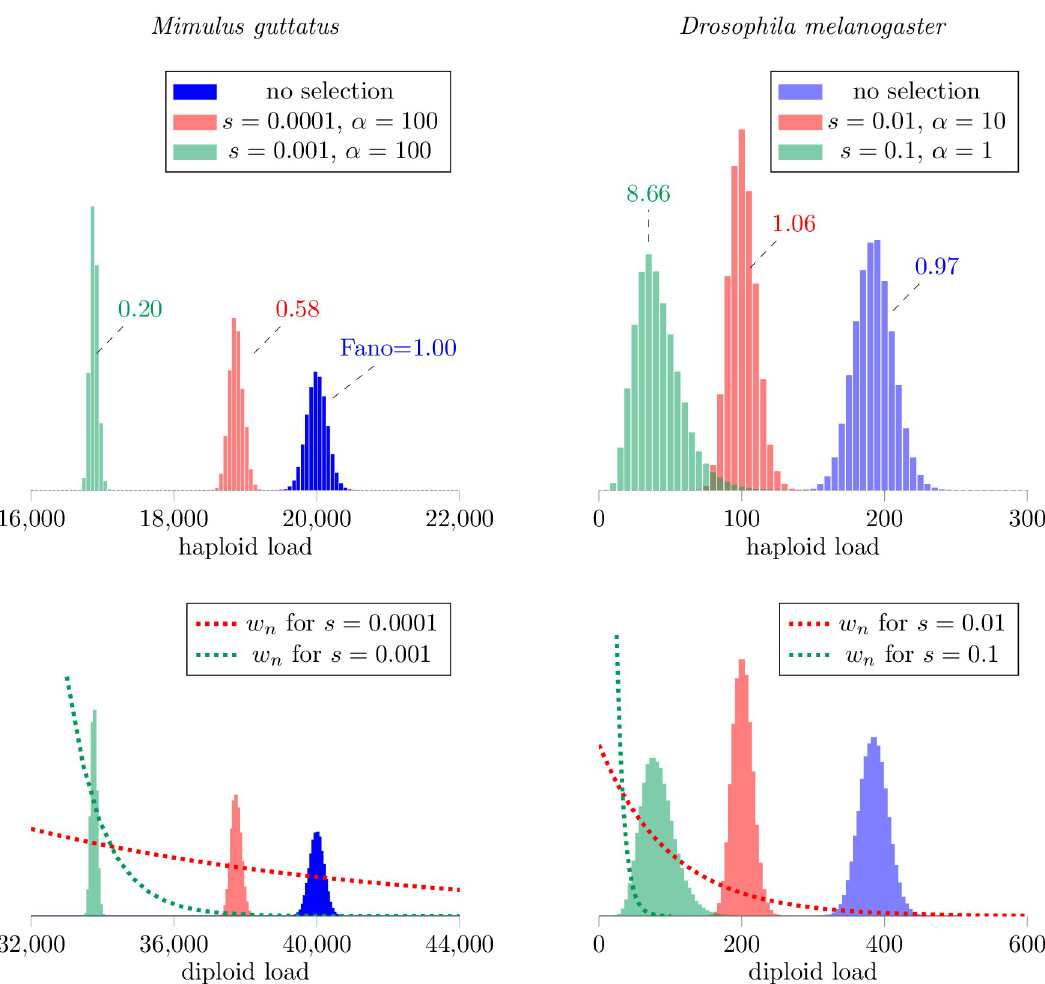
Fig 6. Effect of selection on the distribution of TE load. Stationary population distributions of TE abundance with and without selection predicted by the master equation model, Eqs (31) and (32). Parameters: selection coefficient s as in legends. Mimulus : ν = 0.1, m = 10 9 ; η 0 , η = 2000, 0 (blue), 200, 0.095 (red), 20, 0.099 (green). Drosophila : ν = 0.1, m = 5000; η 0 , η = 20, 0 (blue), 1, 0.1 (green), 2, 0.1 (red).